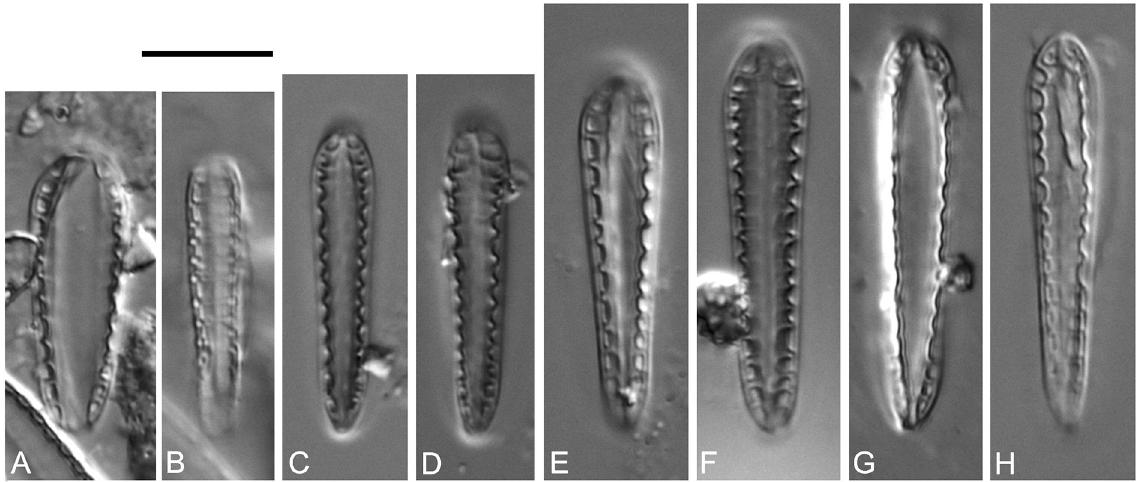
Fig. 7. Surirella congolensis sp. nov., from the holotype slide BR 4399, Lomami River, DR Congo, LM (DIC), girdle views. Scale bar = 10